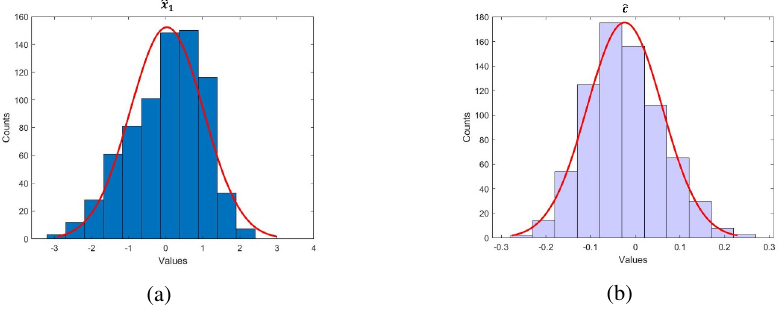
Figure 1: Histograms of ˆ x 1 and ˆ c , with a Gaussian distribution overlaid. We can see that they roughly follow a Gaussian distribution, therefore we assume that the true values also follow a Gaussian